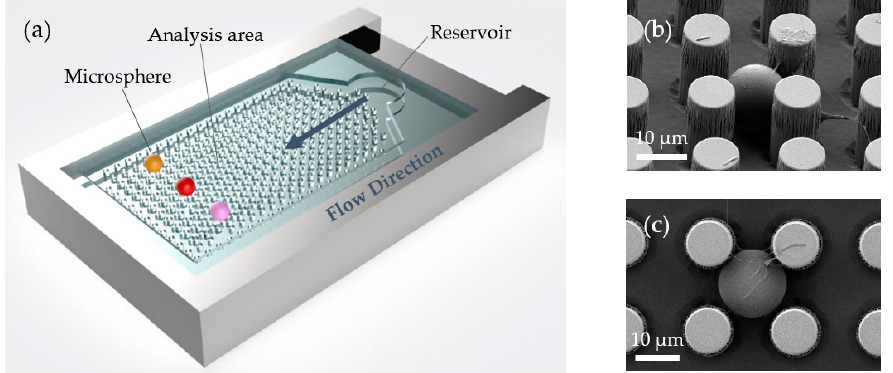
Figure 1. ( a ) Schematic of the open microfluidic chip (not to scale) with caged whispering gallery microspheres incorporated. ( b , c ) SEM micrographs of the polystyrene microspheres caged within the open microfluidic chip.